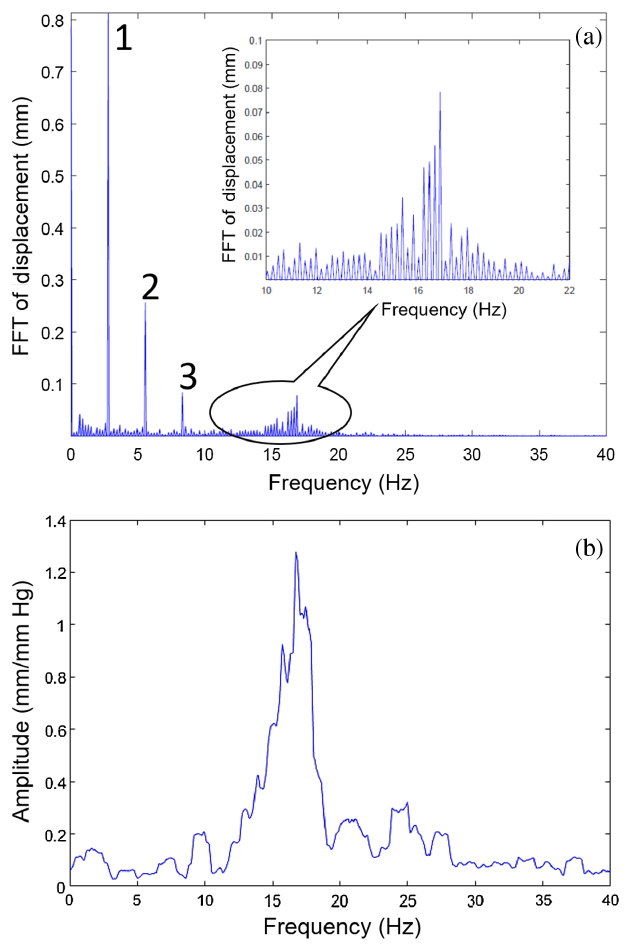
FIG. 4. Donor XI at 170 bpm: (a) FFTof the bending oscillation in vertical direction where the numbers 1, 2 and 3 correspond to the first, second and third harmonics, respectively; (b) FRF between the bending oscillation and the inlet